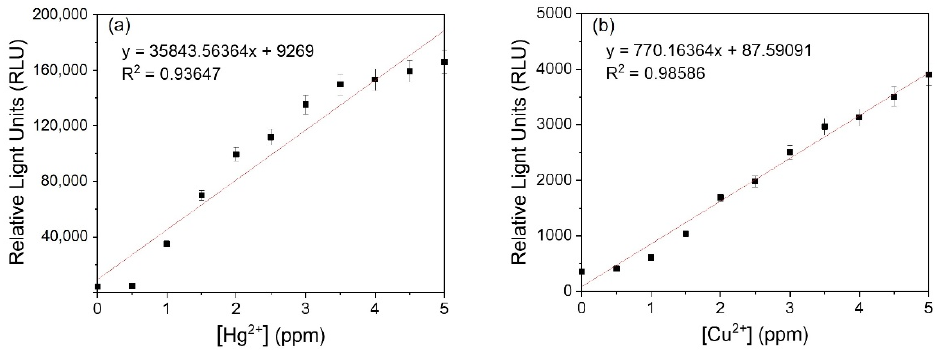
Figure 2. The correlations between RLUs and target metal concentration of luminescent ( a ) mercury- sensing strain and ( b ) copper-sensing strain.